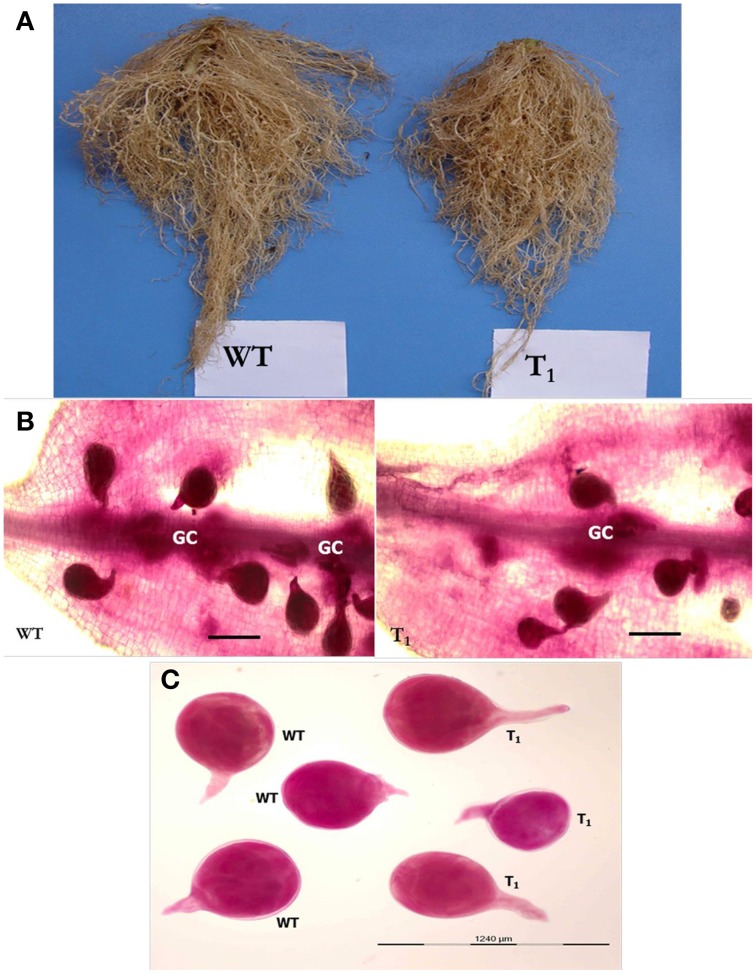
Comparison of M. incognita infection in transgenic (T1) and wild type (WT) tomato plants at 35 DPI. (A) Intensity of galling was comparatively higher in control plants than the transgenic plants. (B) Stained females of M. incognita inside the tomato root. Transgenic plants had supported less number of females compared to wild type plants. GC—giant cell (Scale bar = 500 μm). (C) Size and shape of mature females of M. incognita isolated from tomato roots. Nematodes were stained with acid fuchsin (Byrd et al., 1983).